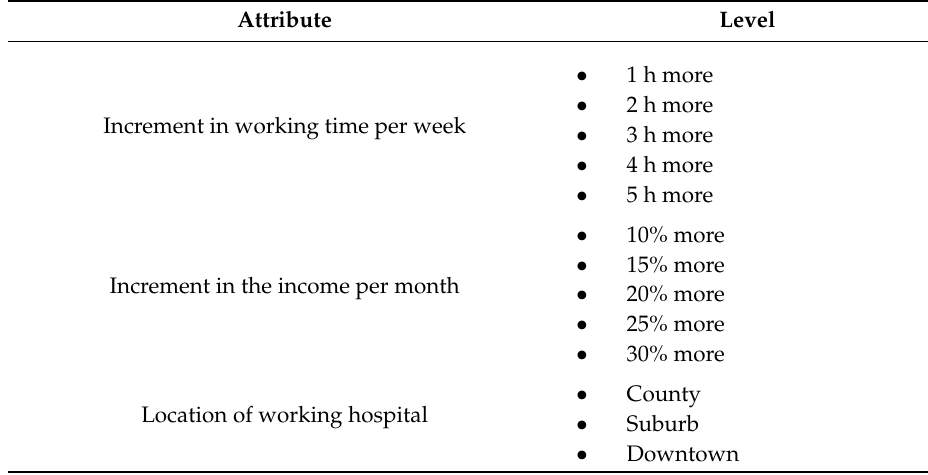
Table 1. The attribute and levels of the discrete choice experiment